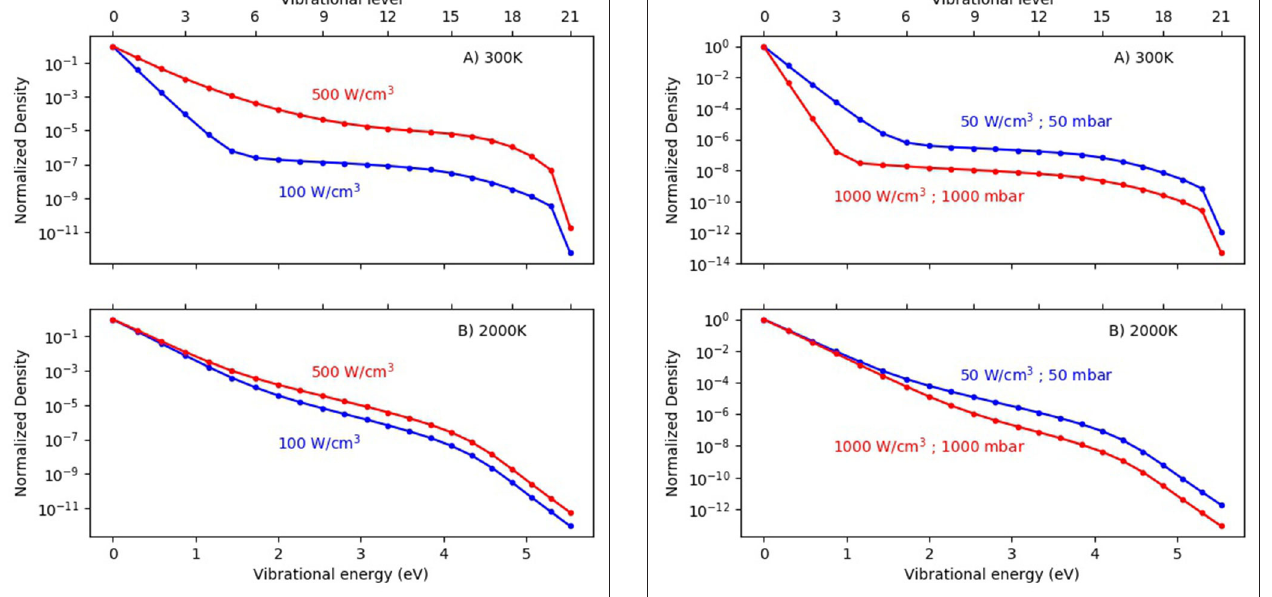
FIGURE 7 | Calculated vibrational distribution functions (VDFs) in a MW plasma, for a gas temperature of 300K (A) and 2,000K (B) and a pressure of 100 mbar, at two different power densities. Adopted from Berthelot and Bogaerts (2017) with permission.